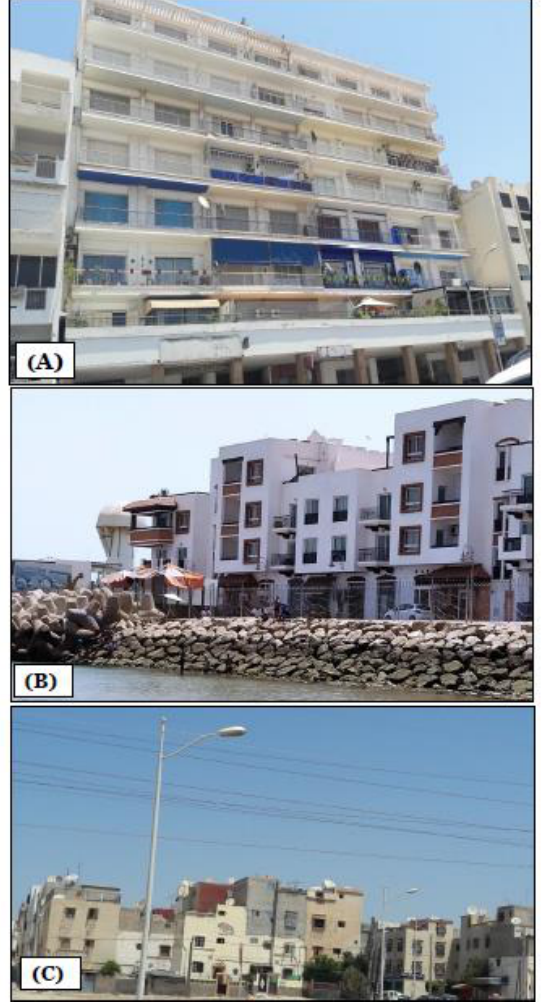
Figure7 . Type of buildings in the study